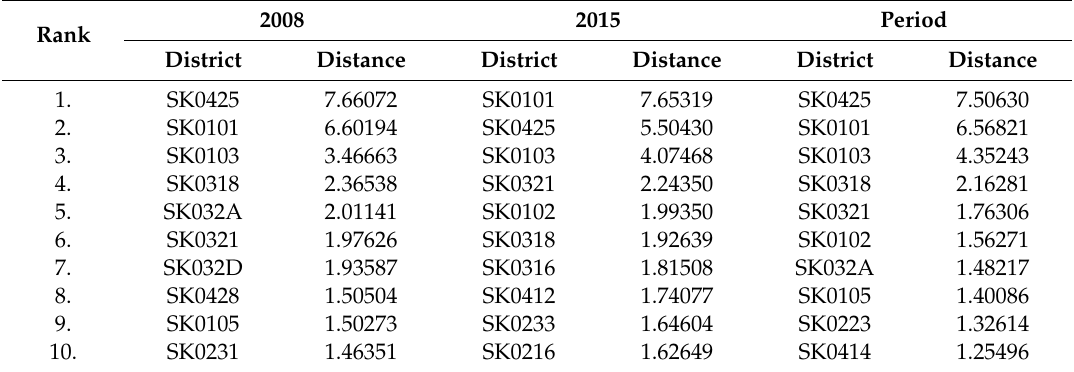
Table 2. The ten most extreme districts for the medical equipment distribution.